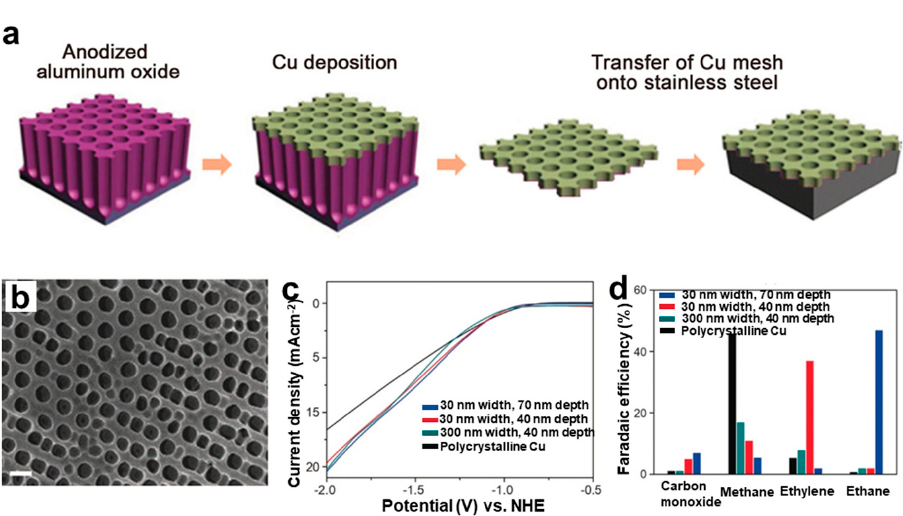
Figure 12. ( a ) Preparation scheme and ( b ) SEM images of copper mesoporous electrode. Scale = 300 nm. ( c ) Linear sweep voltammetry curves and ( d ) chemical selectivity at − 1.7 V vs. normal hydrogen electrode (NHE) of four electrodes with different pore widths and depths. Reproduced with permission [87]. Copyright 2017,